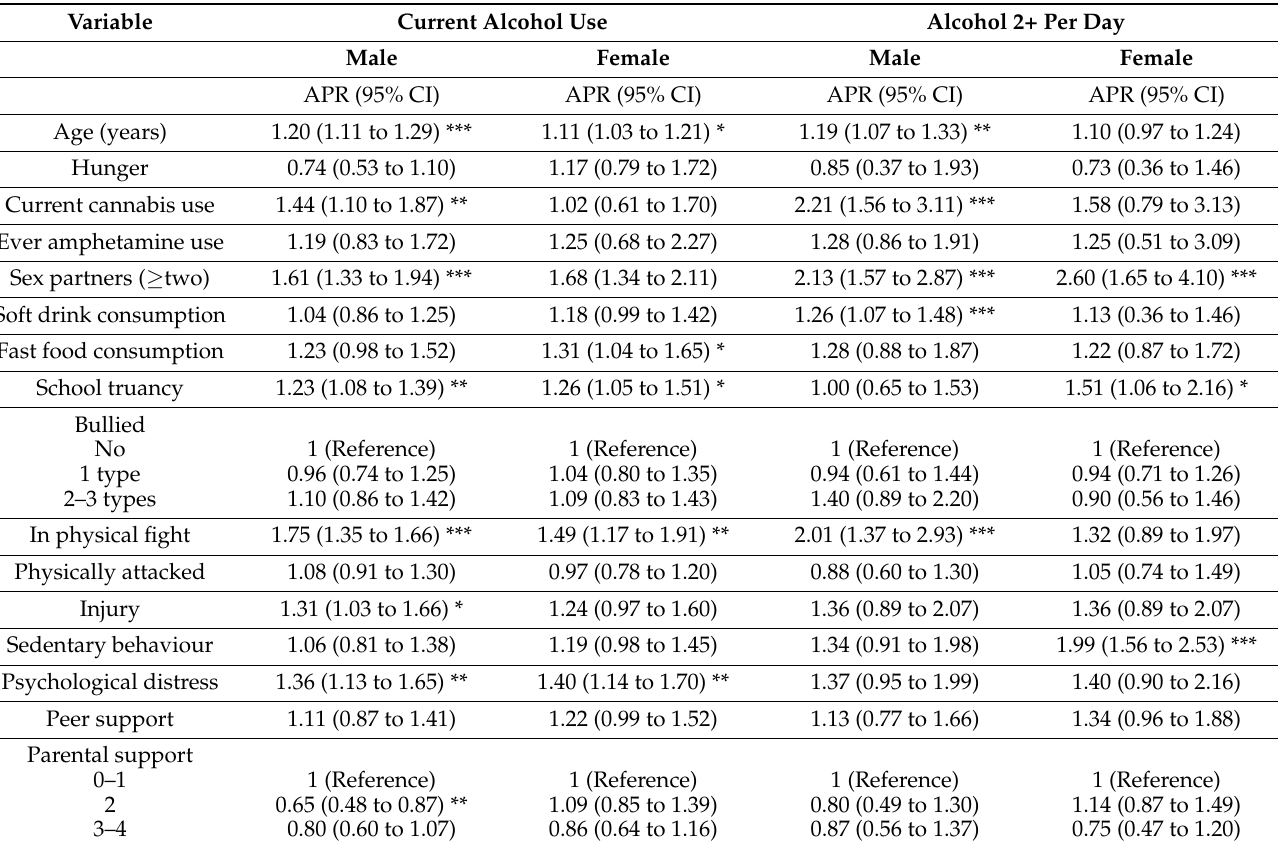
Table 3. Associations with current alcohol use and heavy alcohol use by